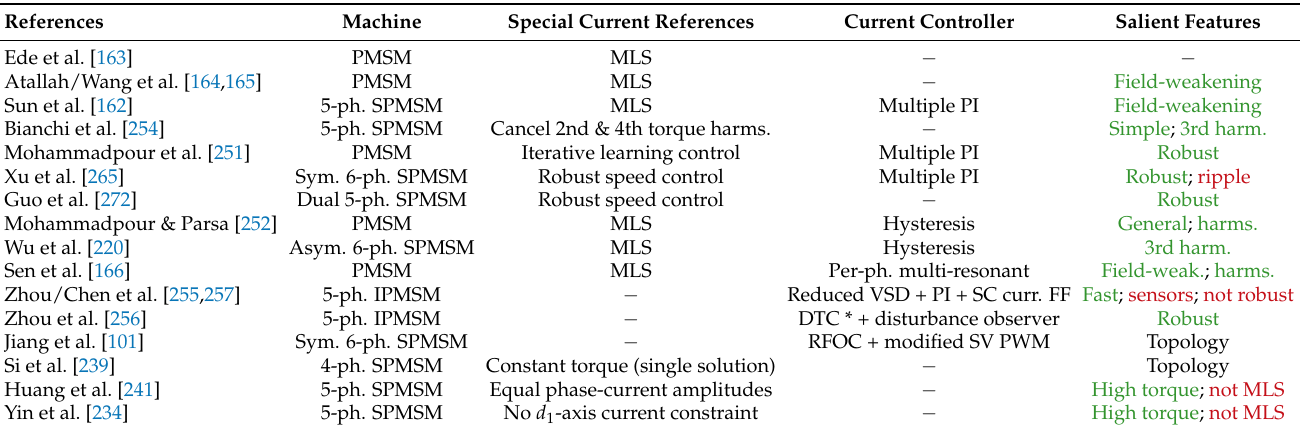
Table 14. Current control methods for reducing torque ripple under phase SCs (Section 5.3.3.3) in multiphase applications in the